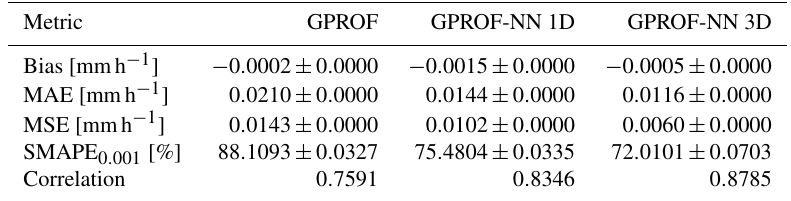
Table C6. The same as Table 5 but for RWP.